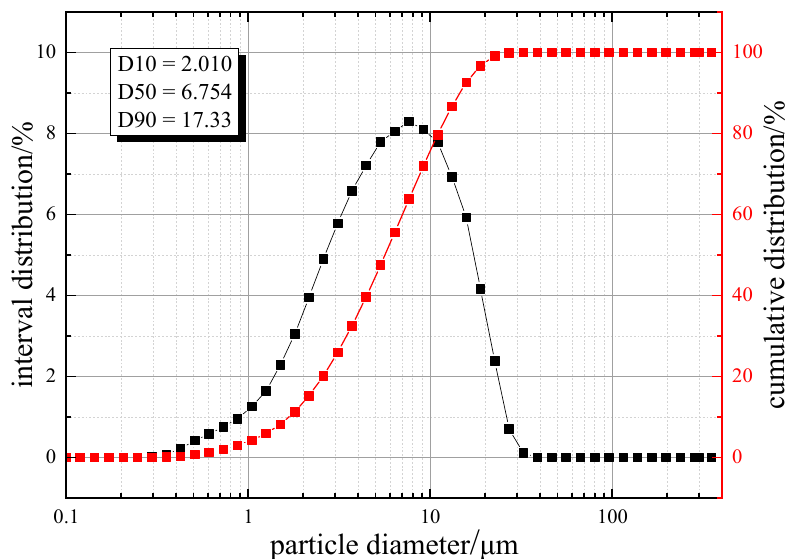
Figure 3. Particle size distribution of blast furnace